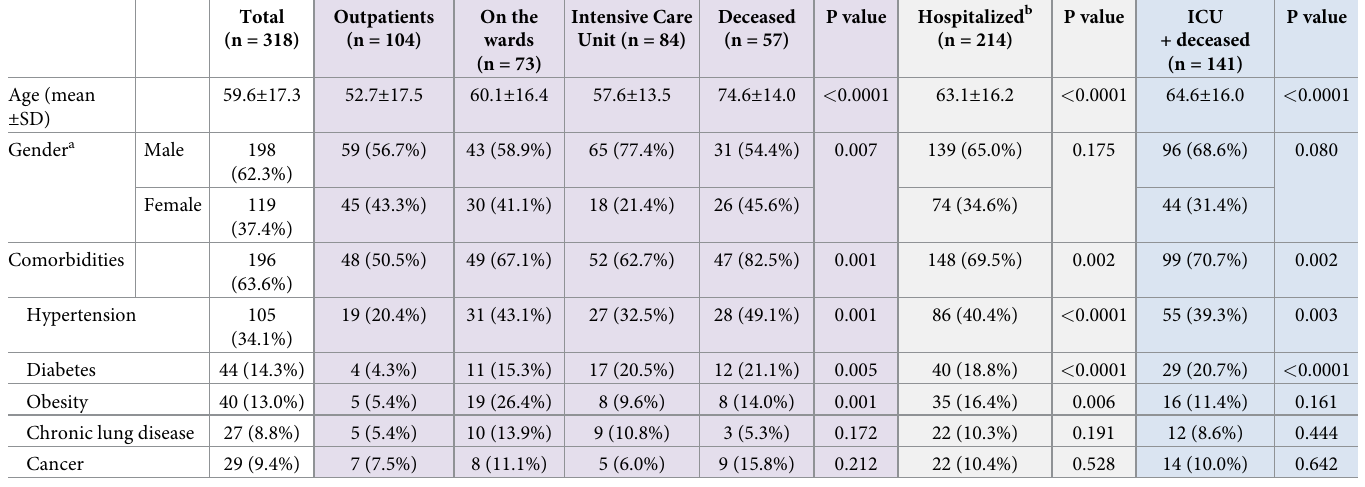
Table 2. Characteristics of each group of patients included in the